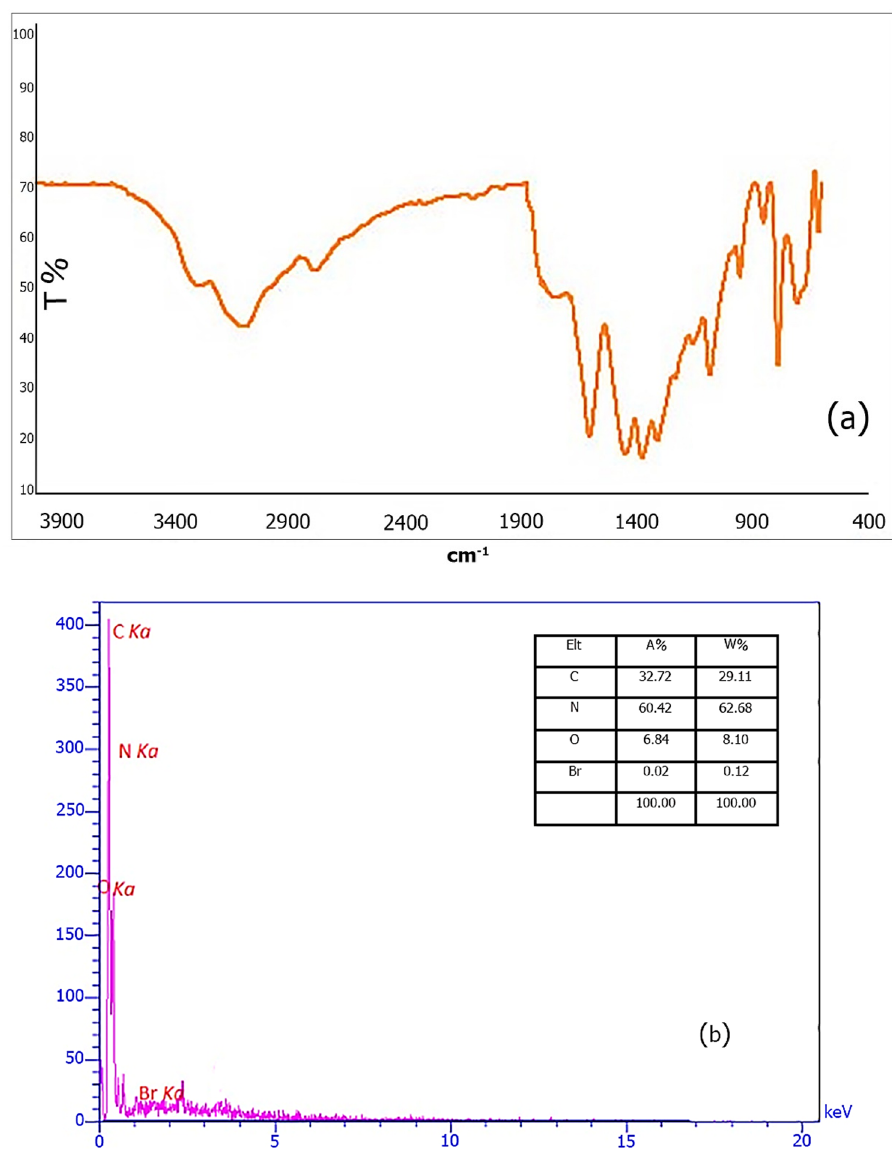
Figure 9. EDX ( b ) and FT-IR spectra ( a ) of g-C 3 N 4 @l-arginine after the five-times